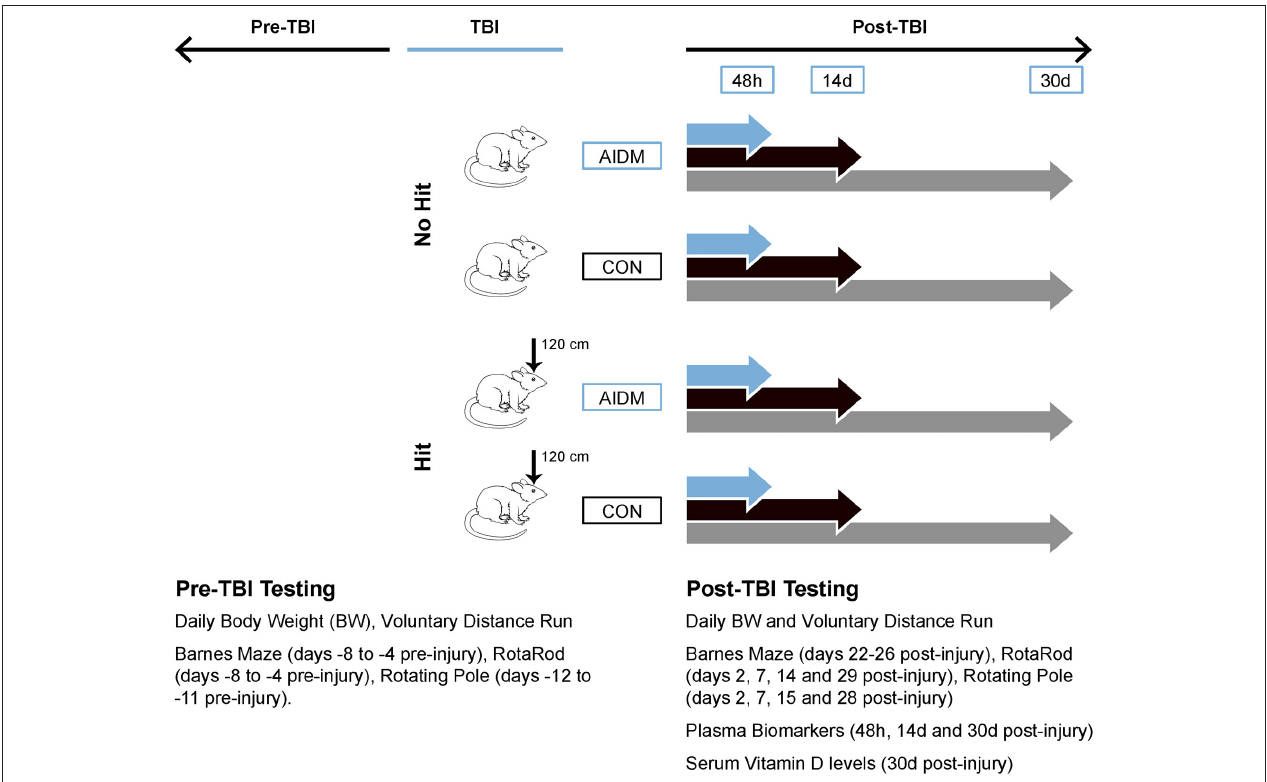
FIGURE 1 | Workflow diagram of study’s experimental design. Using a 2 x 2 design, male, Wistar-Han rats were randomly assigned to 1 of 4 groups: TBI-exposed (Hit) or non-TBI (No Hit), and either anti-inflammatory (AIDM) or non-supplemented AIN-76A (CON) diets following exposure to TBI. At select time points (48h, 14 days, and 30 days) post-injury, plasma and brain (frontal cortex) tissues were harvested. Physiological and behavioral measures pre- and post-TBI are listed in the inset. 120cm, height from which 500g slug was dropped; BW, body weight; TBI, traumatic brain